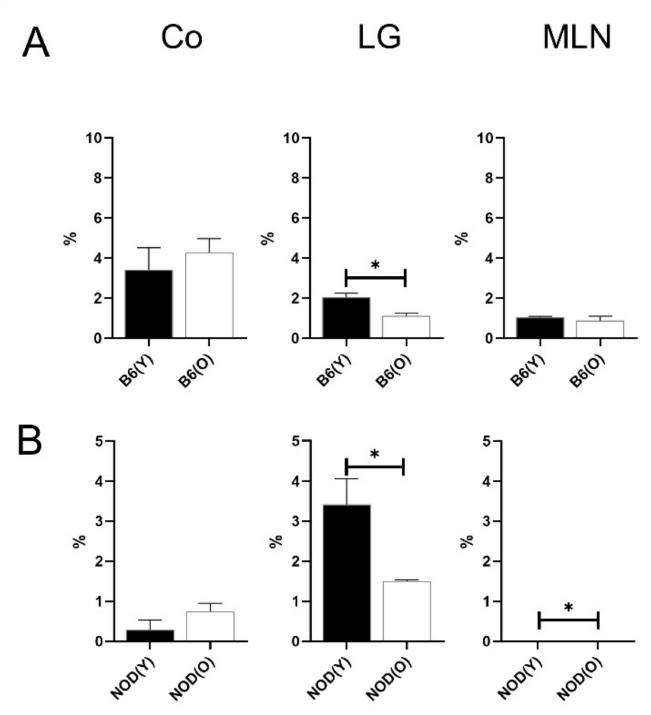
Figure 7. Distribution of macrophages in B6 ( A ) ( n = 4) and NOD.B10.H2 b ( B ) mice ( n = 4). The total number of CD45 + cells was used as the denominator to compensate for the actual frac- tion of each subset in corneolimbus and LG. In MLN, the percentage of subsets was calculated as the percentage within total cells. The percentage of lacrimal glandial MHC-II hi macrophage (CD11b + CD11c − CD24 − MHC-II hi ) was significantly lower in aged than young mice in both mice ( p = 0.010 in B6, p = 0.024 in NOD.B10.H2 b , respectively). In contrast, MLN showed a considerably increased proportion of MHC-II hi macrophage in aged NOD.B10.H2 b mice ( p = 0.039). All experiment results were tested for statistical differences using unpaired, two-tailed independent t-tests. Data are expressed as the mean ± standard error of the mean. B6, C57BL/6; NOD, NOD.B10.H2 b ; DC, dendritic cell; CO, corneolimbus; LG, lacrimal gland; MLN, mesenteric lymph node; B6(Y), young B6 mice; B6(O), aged B6 mice; NOD(Y), young NOD.B10.H2 b mice; NOD(O), aged NOD.B10.H2 b mice. * p <